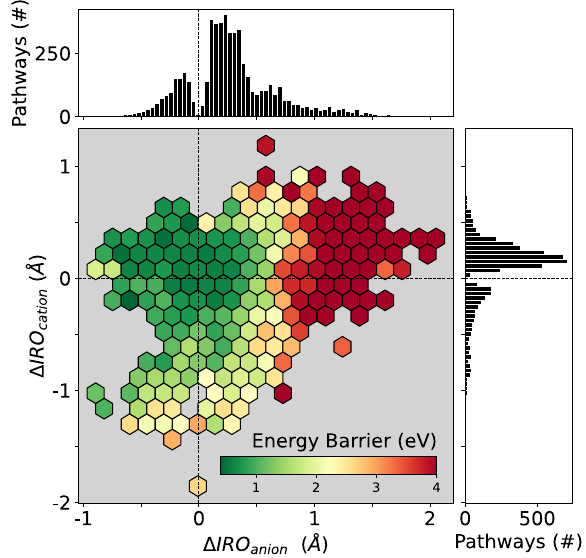
Fig. 3 Understanding the role of sterics and charge on barrier height based on 6797 pathways. The diffusing fl uoride ’ s change in ionic radii overlap was separately evaluated for neighboring anions ( Δ IRO anion ) and cations ( Δ IRO cation ). All measurements were per- formed on the IDPP-relaxed path in R = 7 Å supercells, and the barrier corresponds to the static, midpoint-only approximation discussed in the main text. Each hexagon bin is colored using the average barrier of all pathways in that